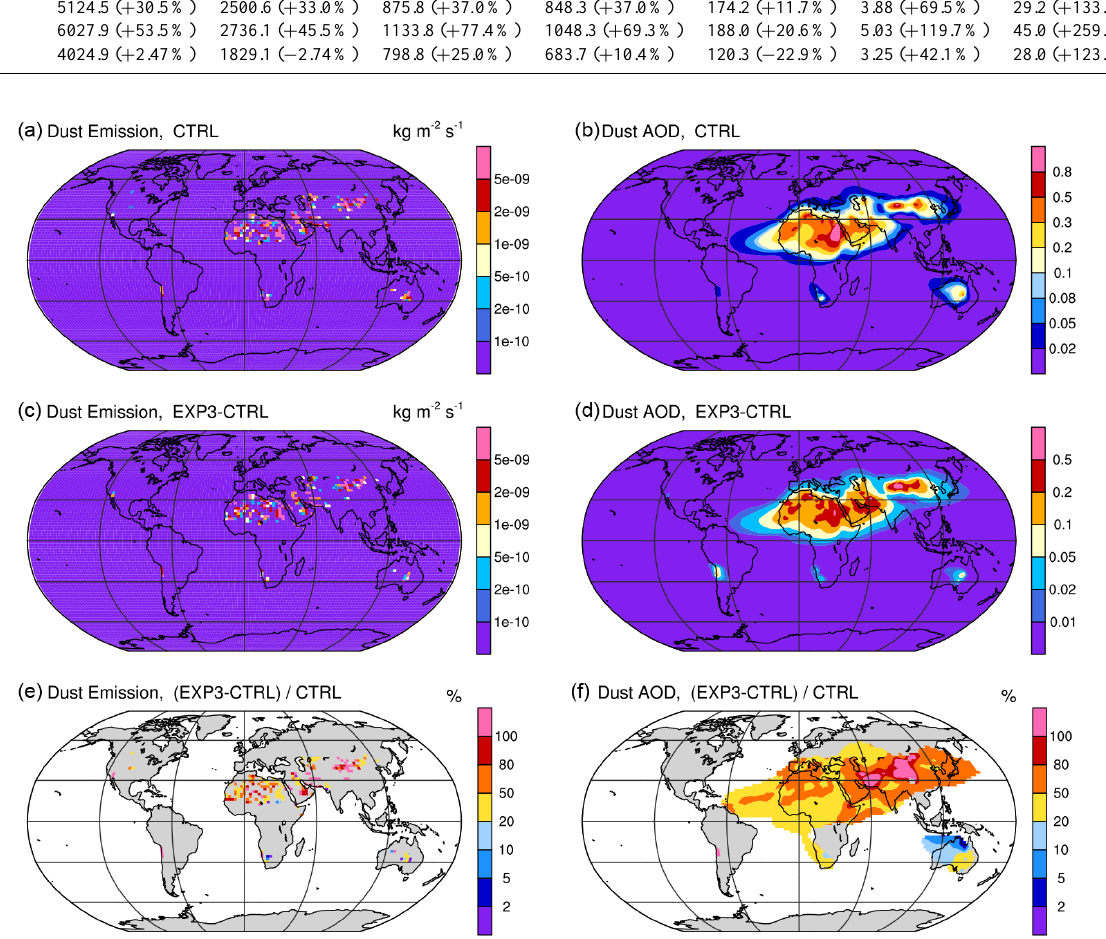
Figure 16. As in Fig. 15 but for dust emission and dust AOD at 550nm. The threshold values for masking out differences in the bottom row are 1 × 10 − 10 kgm − 2 s − 1 for emission and 0.01 for